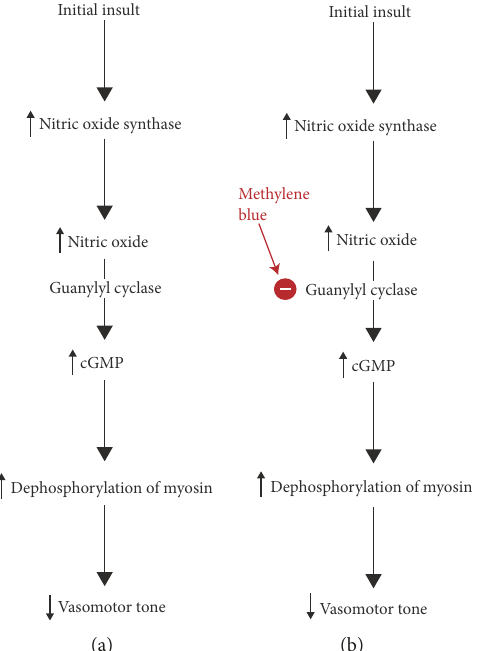
Figure 2: (a) The biochemical pathway of vasodilatory shock as a result of upregulation of the nitric oxide-cGMP pathway. (b) Methylene blue’s site of action, as a guanylyl cyclase inhibitor, resulting in increased vasomotor tone.